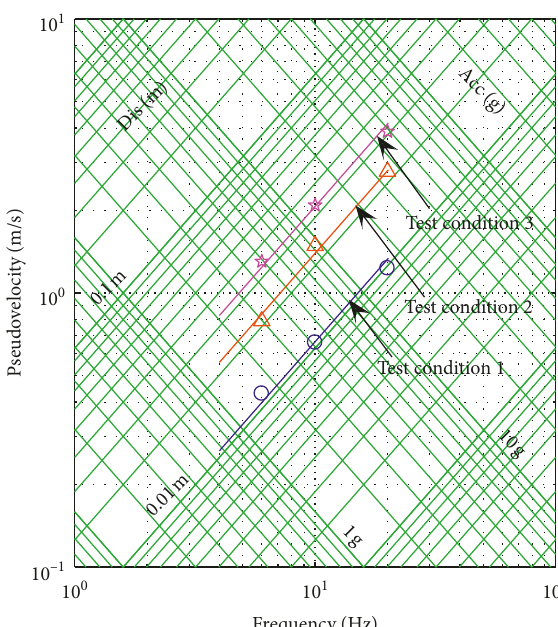
Figure 4: The pseudovelocity data and equal displacement line under different test conditions.